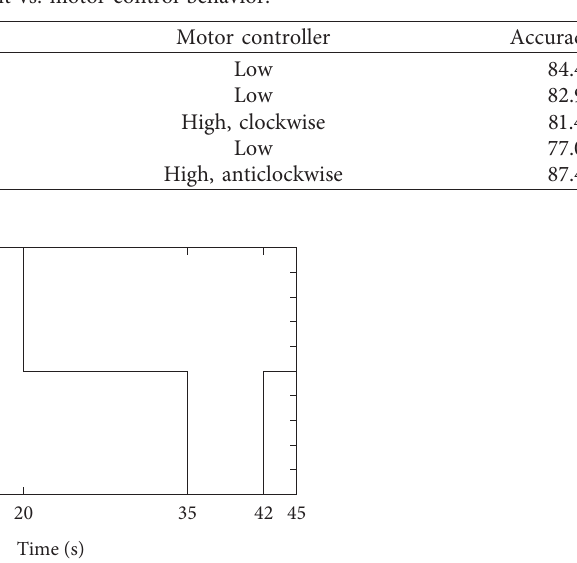
Figure 16: The behaviors of the motor control signal for a single-trial at 42s of